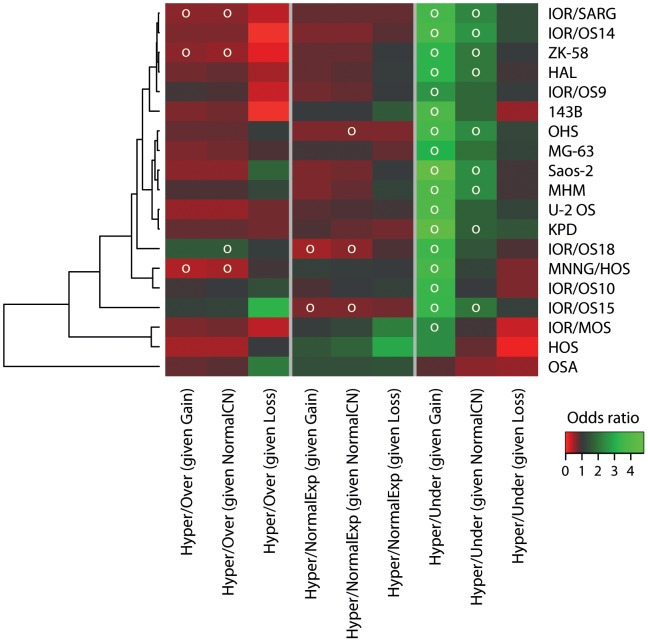
Data dependencies for three-way combinations.Heat map plots visualising the odds ratio and significance of data dependencies, with unsupervised hierarchical clustering of the cell lines, for combinations of hyper-methylation and mRNA expression, conditioning on the DNA copy number status. The colours of the heat map plot represent the odds ratio for a gene of having one type of aberration given that it has another type of aberration. Green, positive association (odds ratio >1); black, no association (odds ratio = 1) and red, negative association (odds ratio <1). A white circle indicates significance (Benjamini & Hochberg-corrected chi-square p-value <0.05). Exp, mRNA expression; CN, DNA copy number.